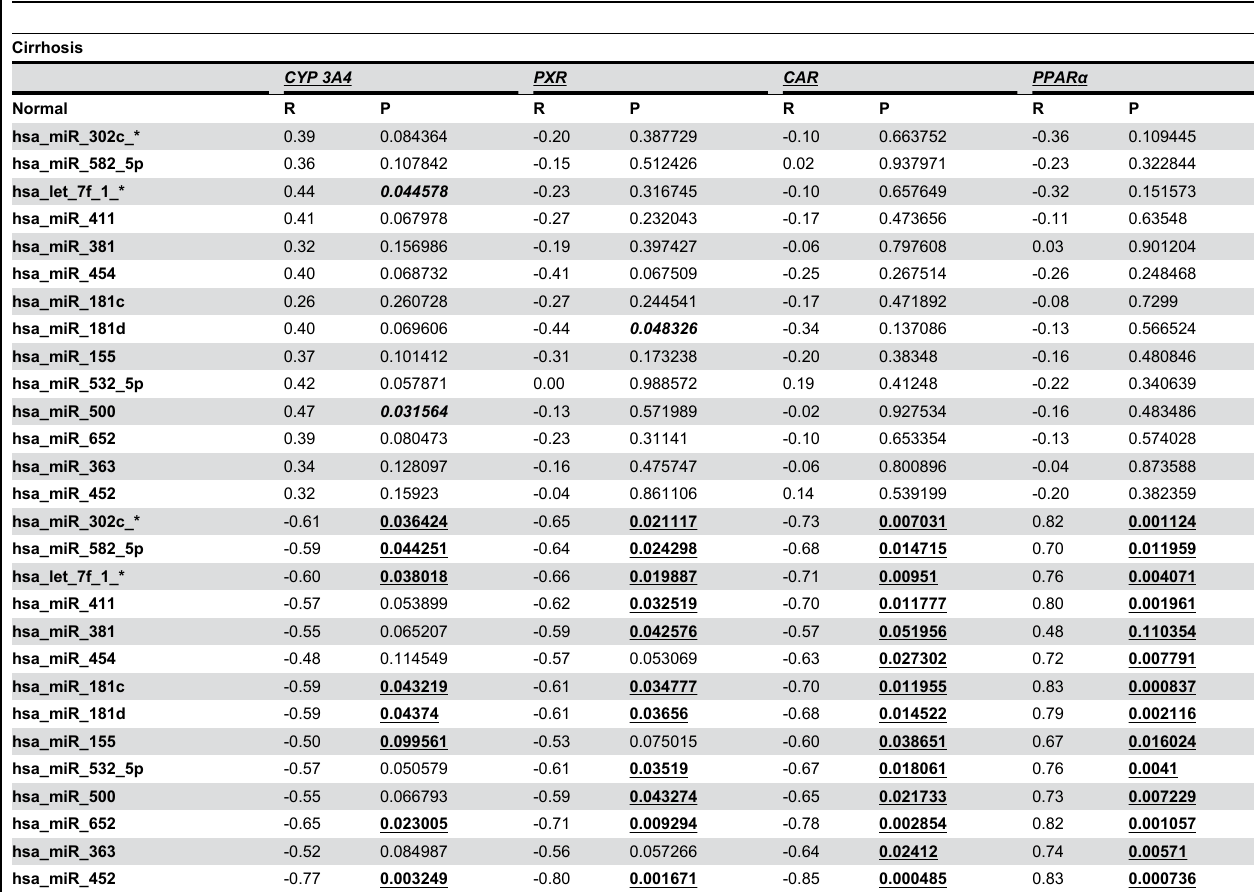
Table 4. Correlation analysis between miRNA and mRNA expression of CYP3A4 and select nuclear receptors (PXR, CAR and PPARα) in cirrhosis and normal liver tissue.